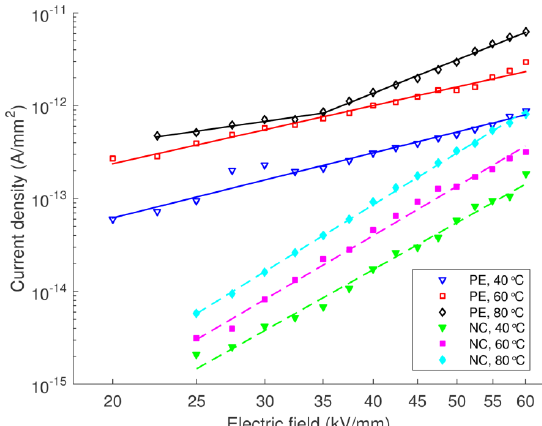
Figure 3. Characteristics of isochronal current densities versus applied electric field for LDPE and LDPE / Al 2 O 3 3 wt% nanocomposite (denoted respectively as PE and NC) at various temperatures. Markers are the measured points, whereas lines represent the fittings.